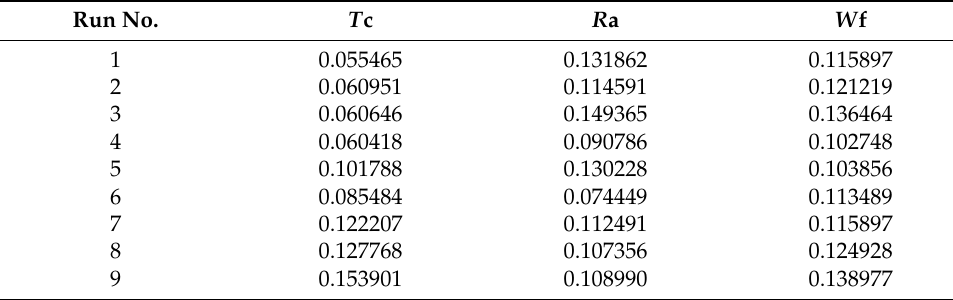
Table 10. Performance indicator’s standardized and weighted decision